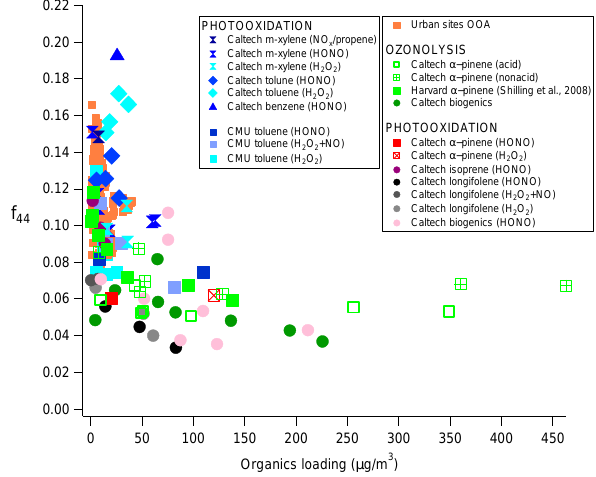
Fig. 8. f 44 (highest f 44 observed in the experiment) vs. the OH exposure for SOA formed from the photooxidation of m -xylene and toulene under low-NO x (H 2 O 2 ) conditions (Ng et al., 2007b; Hilde- brandt et al., 2009). Each data point is colored according to the loading of that particular